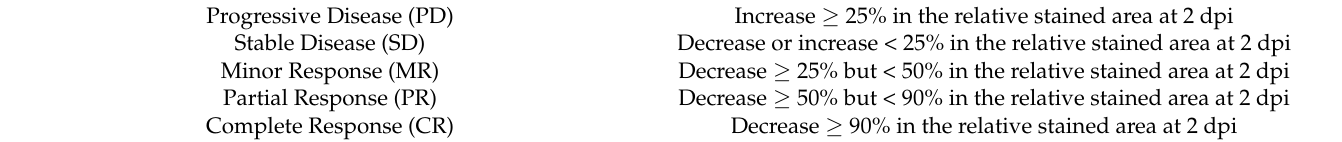
Table 4. Definition of criteria used to define the zPDX response (adapted from WHO standard criteria). Progressive Disease